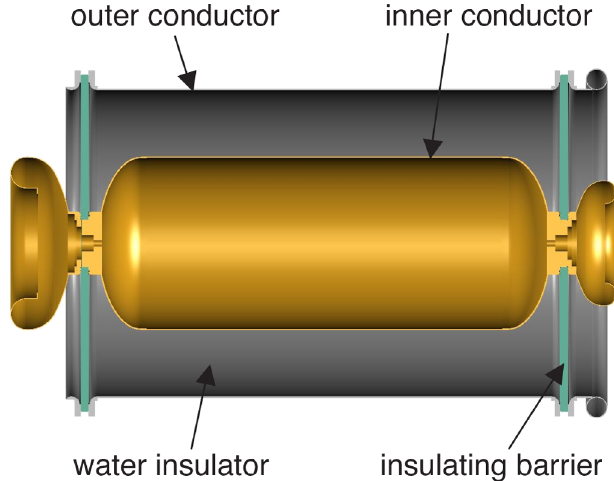
FIG. 1. (Color) Cross-sectional view of a ZR-accelerator intermediate-storage capacitor. The two electrodes have outer and inner radii of 99 and 56 cm, respectively.